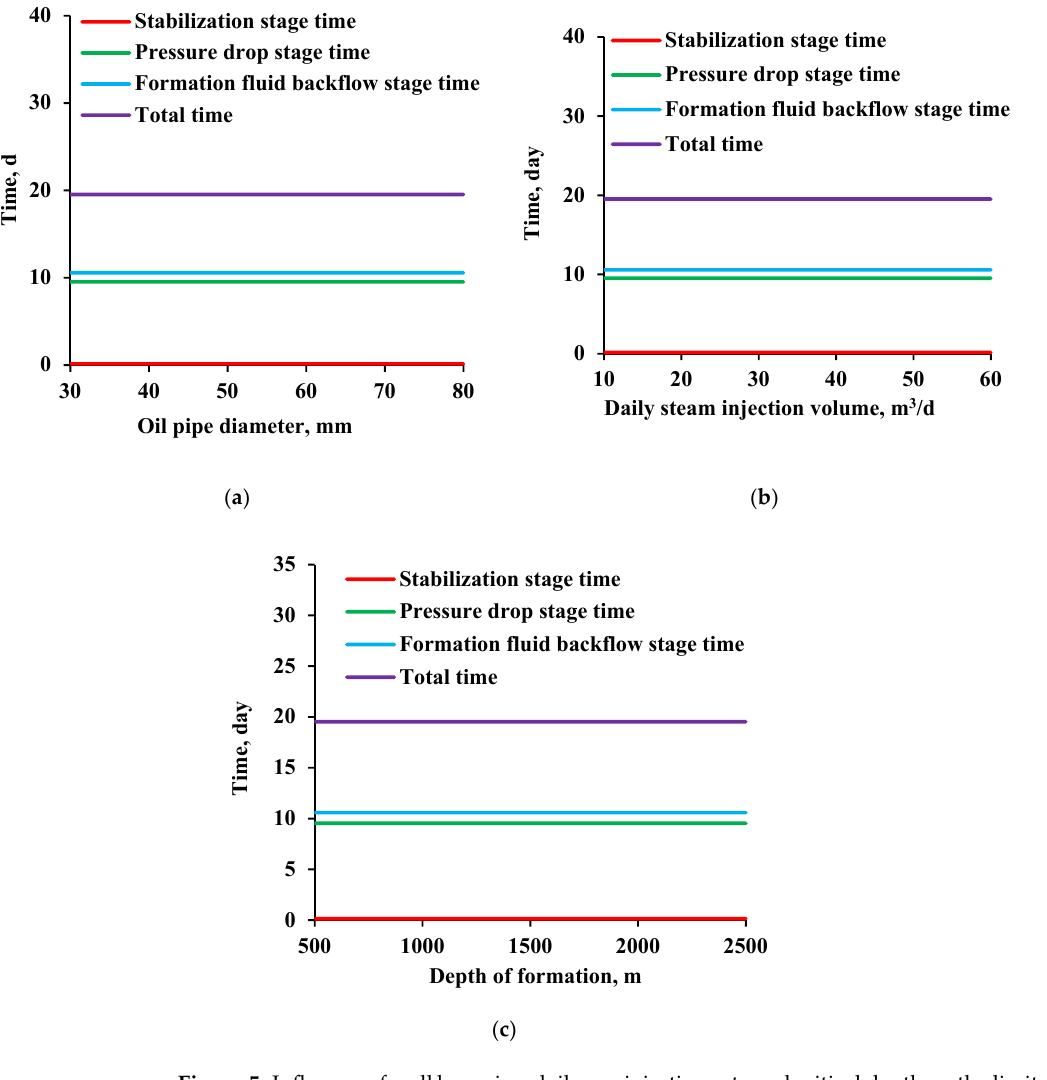
Figure 5. Influence of well bore size, daily gas injection rate and critical depth on the limit shut-in time of a waterproof compound. ( a ) Influence of tubing diameter on the limit shut-in time; ( b ) Influence of daily gas injection rate on limiting shut-in time; ( c ) Influence of critical depth of liquid CO 2 on the limit shut-in time.